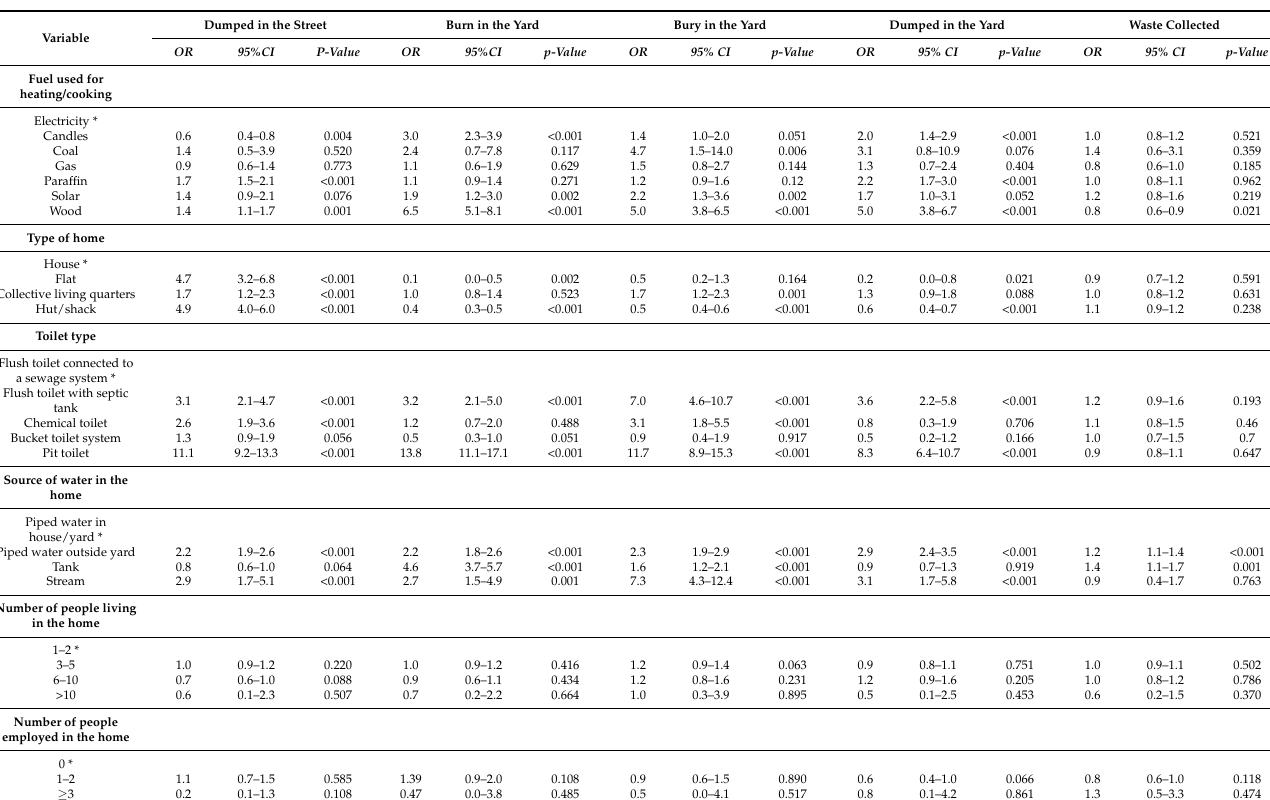
Table 3. Results of multivariate regression of housing characteristics, socio-demographic factors, and environmental health risk factors in relation to waste disposal